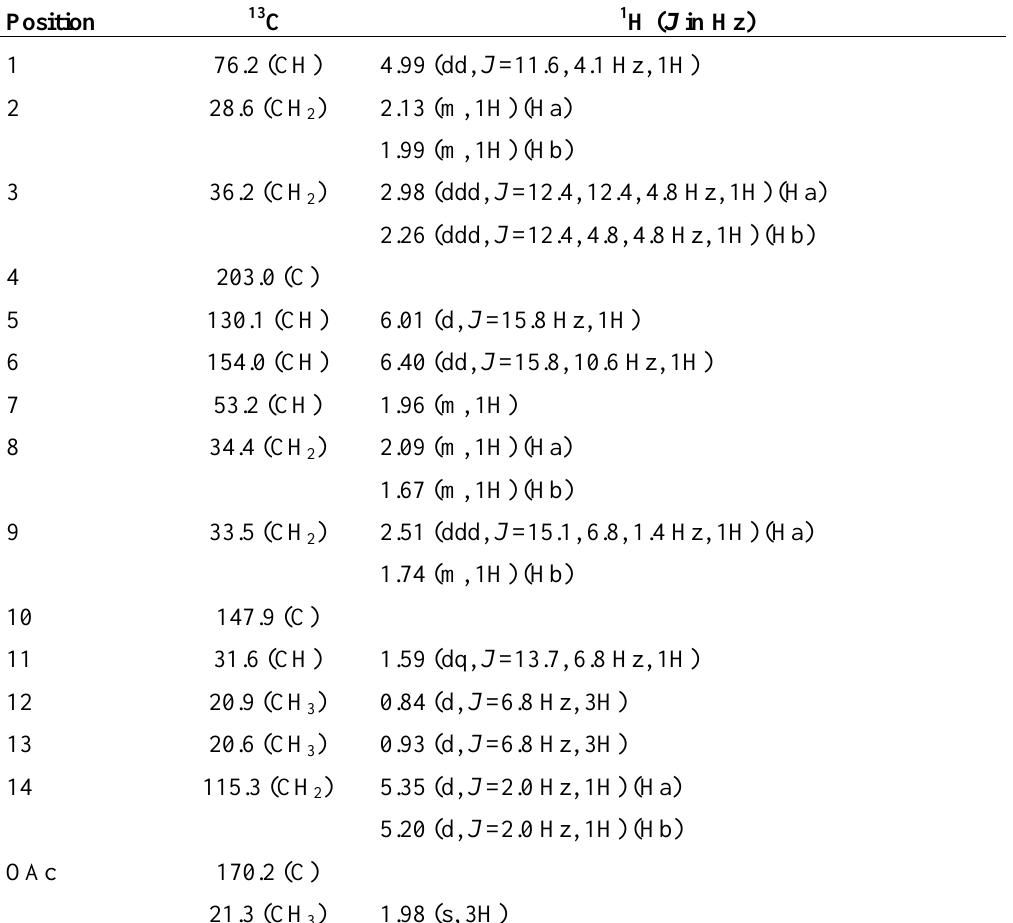
Table 1. 1 H-NMR and 13 C-NMR spectral data of compound 1 (recorded at 600/150 MHz ;  in ppm, J in Hz). in CDCl 3